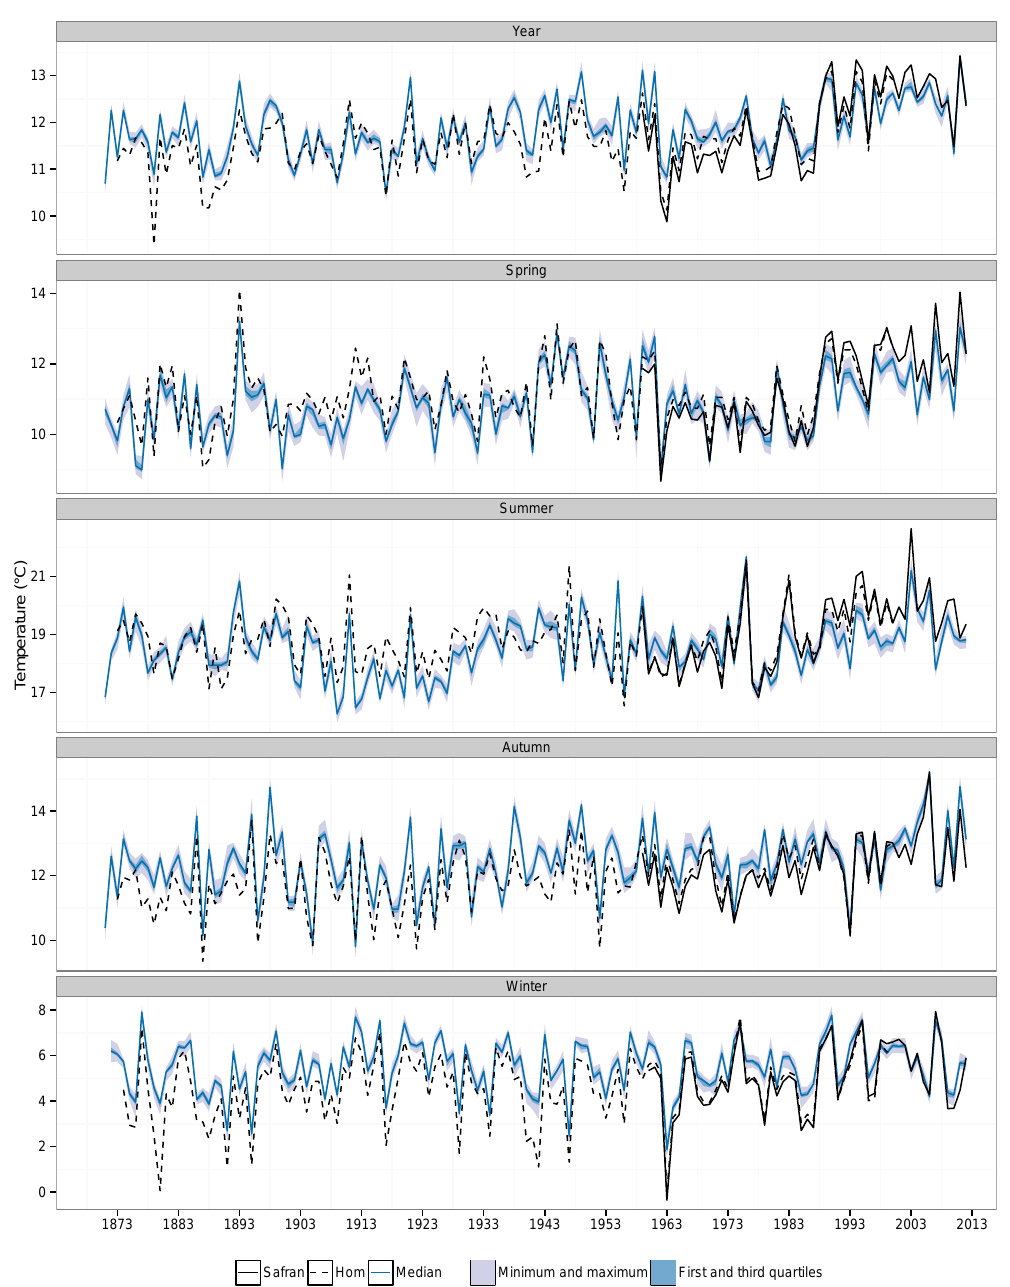
Figure 14. Paris Montsouris temperature homogenized time series, corresponding Safran data and reconstructed series from the stepwise selection at the annual and seasonal timescales over the 1871–2012 time period. Grey and blue ribbons define the range and the interquartile range, respectively, of values from all 25 realizations from the stepwise selection. Note the different scales for the y